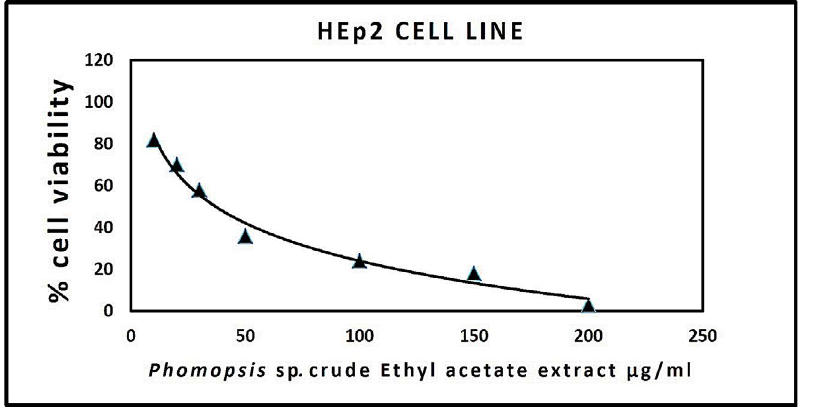
Fig. 7. Graph representing anticancer activity of Phomopsis sp., crude endophytic fungal Ethyl Acetate Extract in HEp2 Cell Line. Table 6. 50 % Maximal inhibition of inhibitory concentration (IC extract endophytic fungi